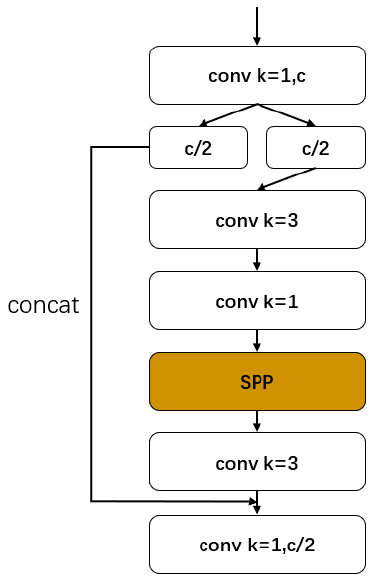
Figure 3. Csp-SPP